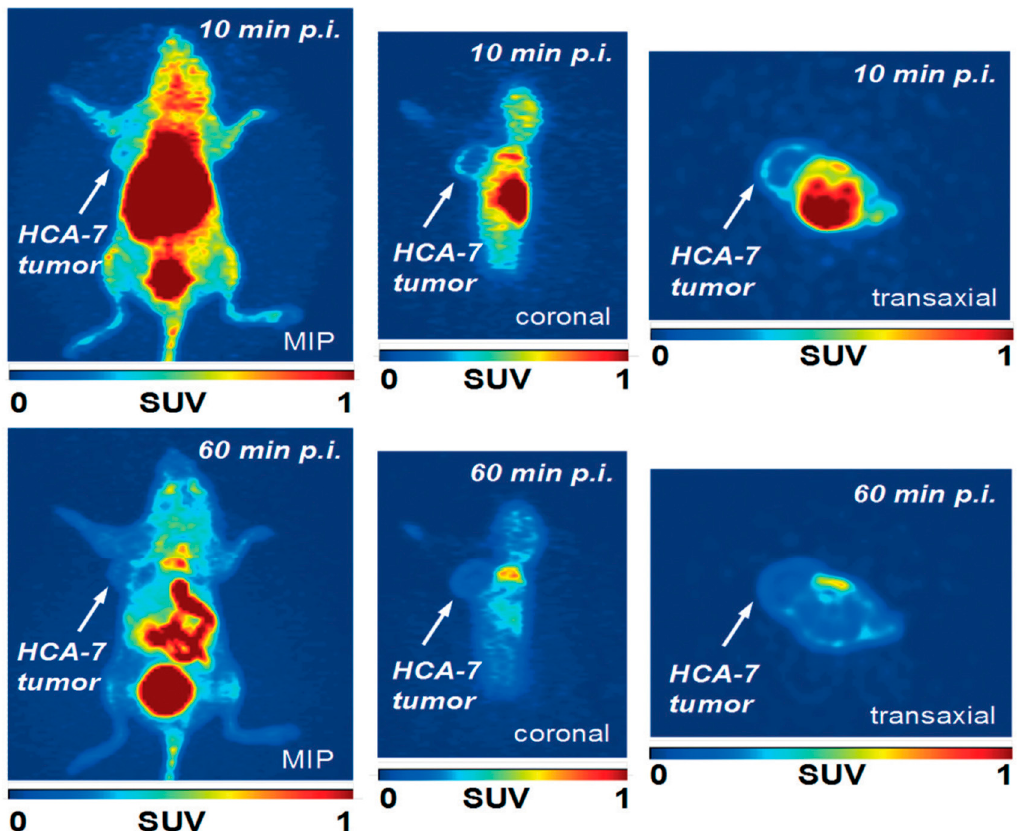
Figure 10. Maximum intensity projection (MIP), as well as coronal and transaxial PET images at 10 and 60 min p.i. of radioligand [ 18 F] 31 in HCA-7-tumor-bearing (left flank) NIH-III mice (injected activity = 2.89 MBq) under isoflurane anesthesia. Figure readapted with permission from publisher [81].